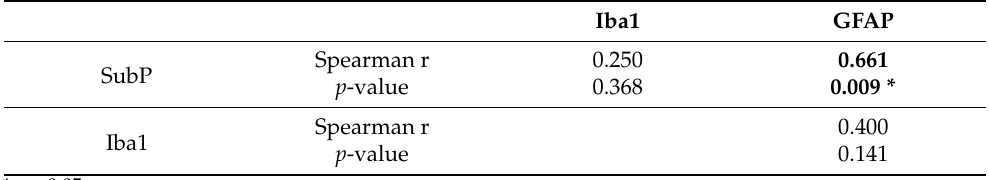
Table 1. Correlation analysis among spinal cord SubP-, Iba1- and GFAP-ir.